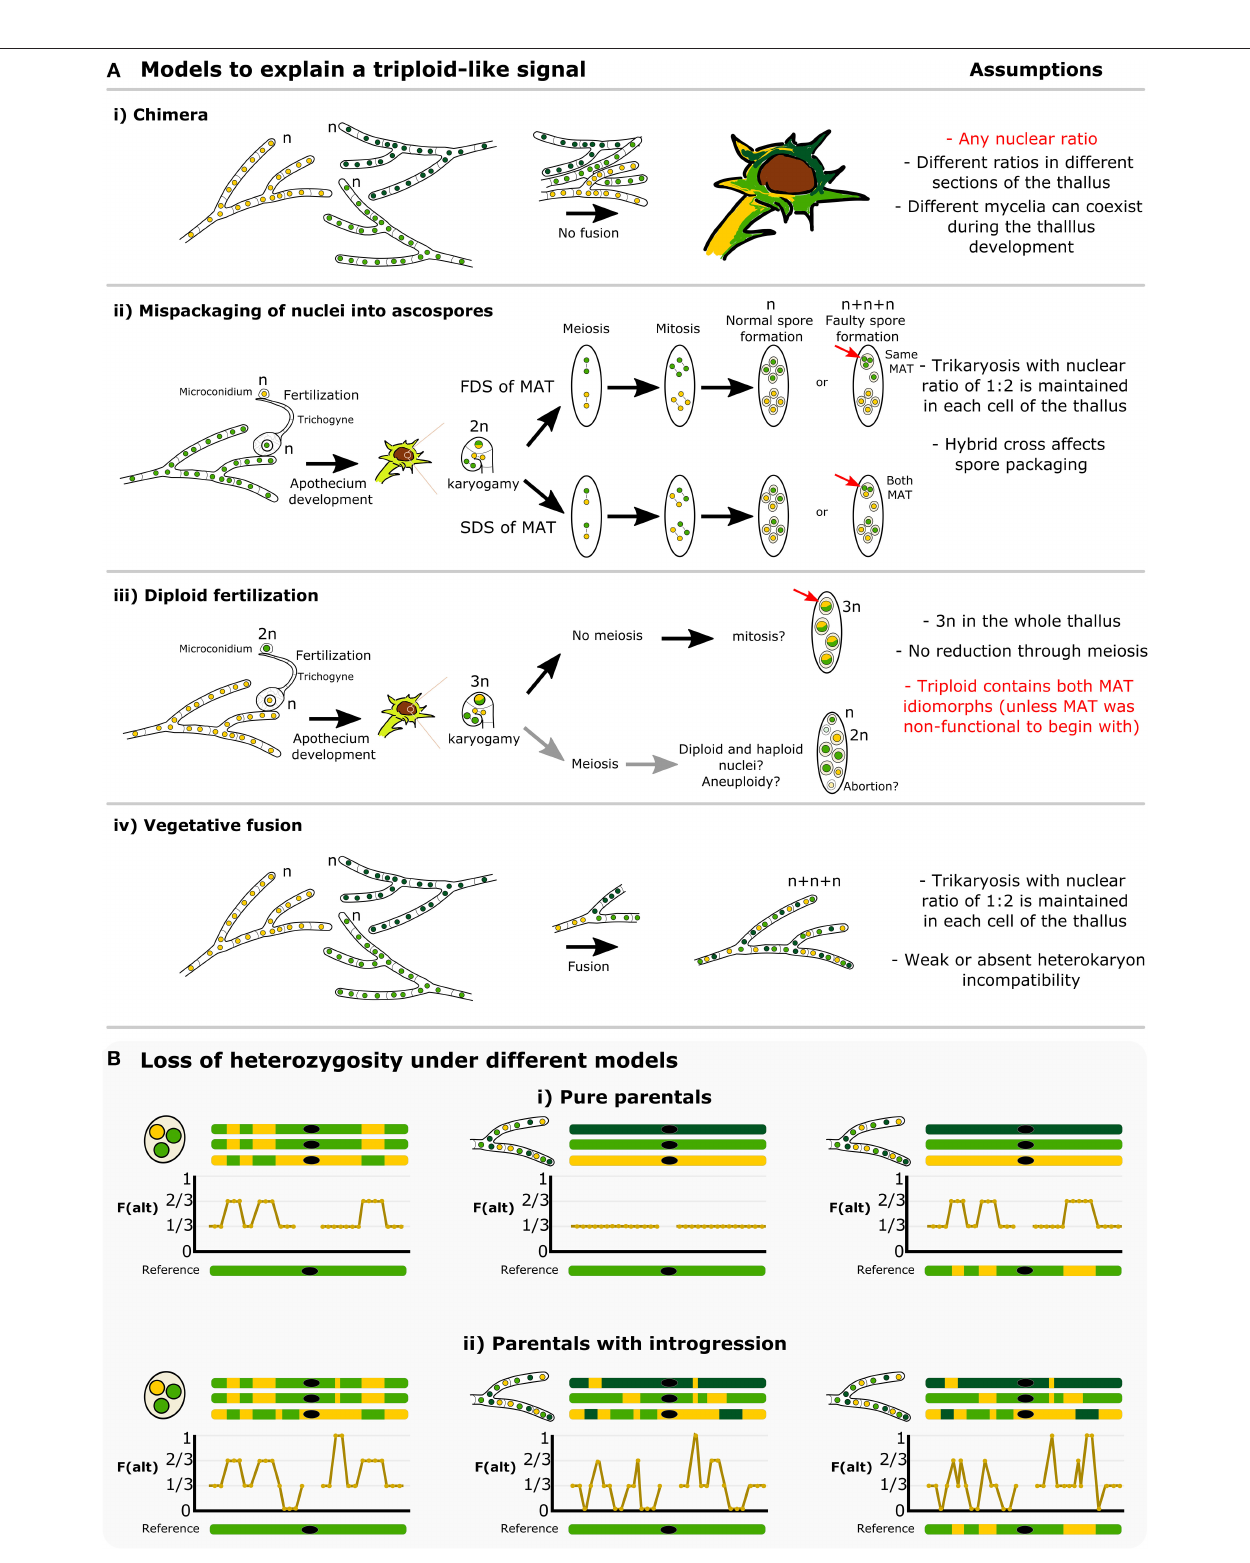
FIGURE 8 | How is a triploid-like hybrid of Letharia formed? (A) We present four main models that can explain a triploid-like pattern where only two out of three (sub)genomes belong to the same species. More complex models or combinations are also possible. The L. lupina allele ancestry is represented by green and the